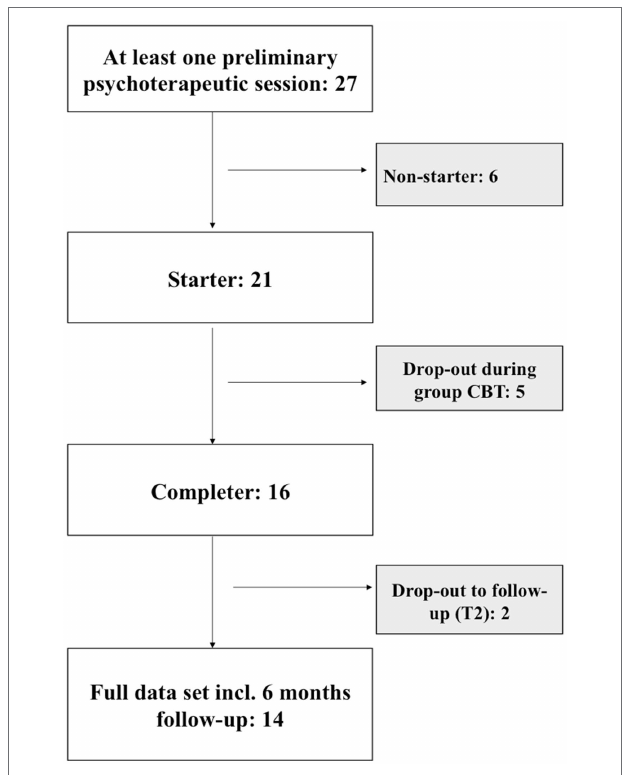
FIGURE 1 | Flowchart of the recruitment